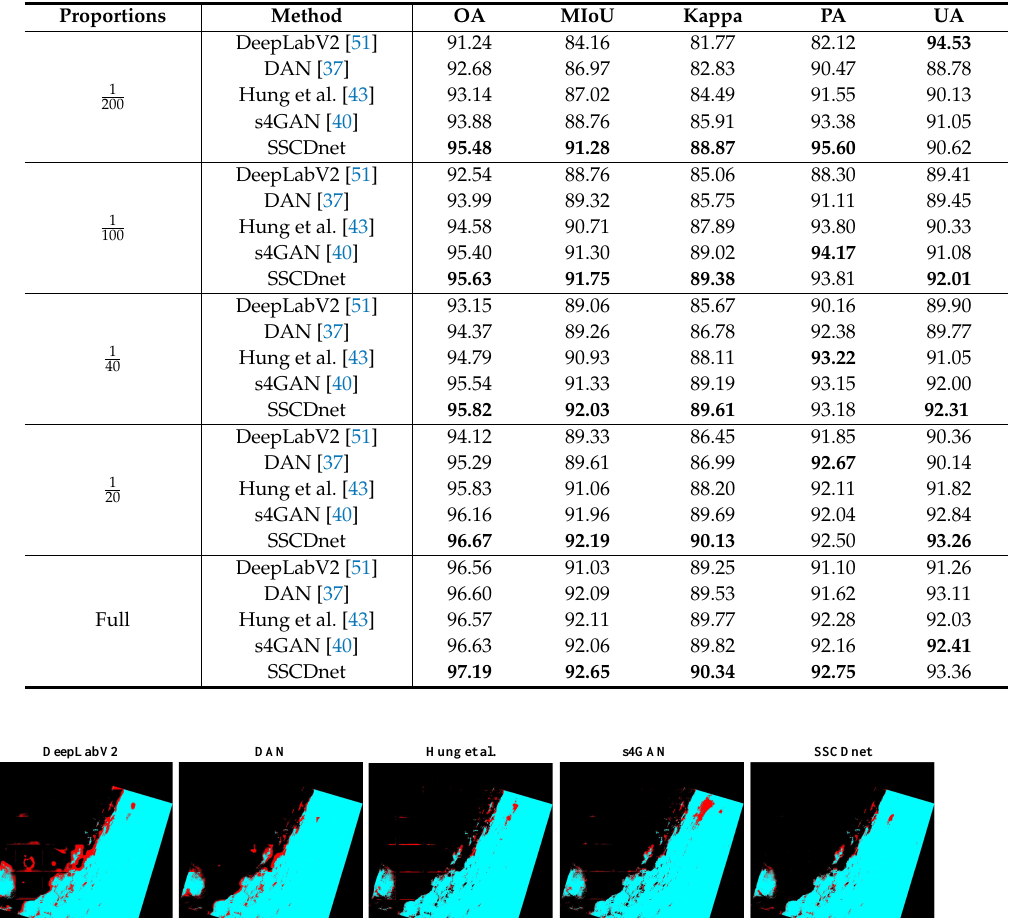
Table 7. Cloud extraction accuracy (%) of different comparison networks on Landsat-8 OLI data. All results are the averaged results on all the testing images.